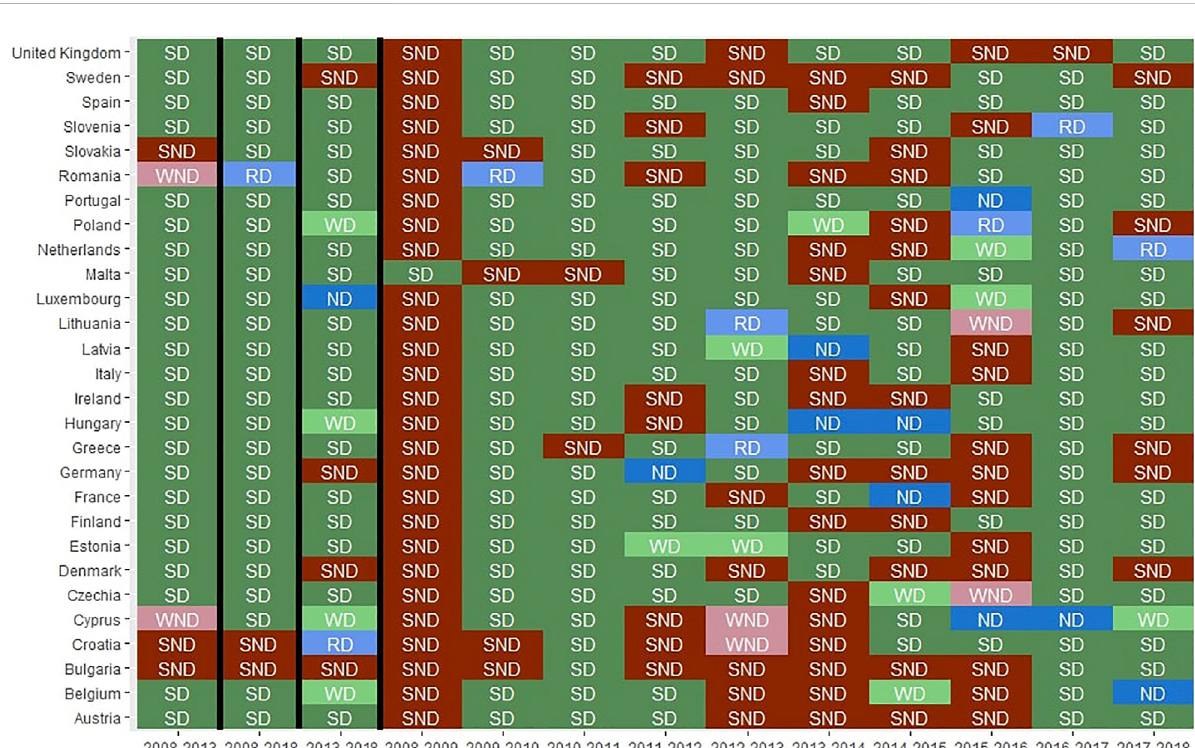
FIGURE 5 CH 4 intensity decoupling. Source: authors ’ calculation based on EEA,